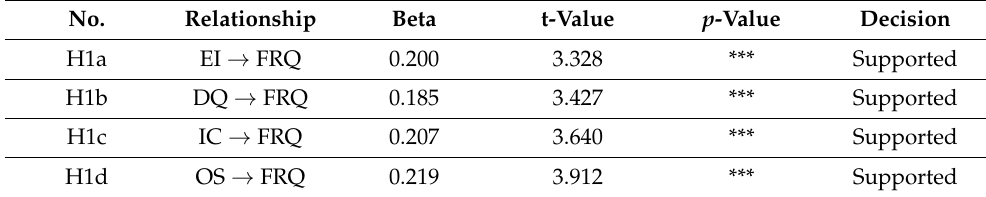
Figure 3. Assessment of structural equation modelling. Table 5. Relationship between creative accounting and financial reporting